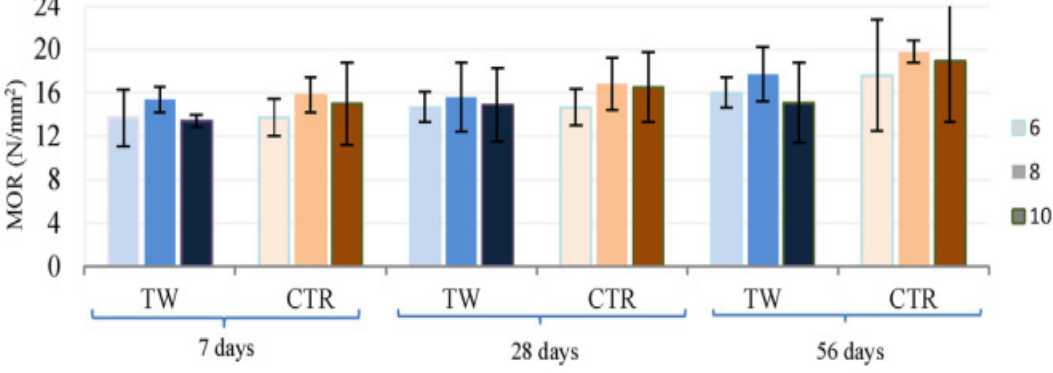
Figure 7. Moduli of rupture of the composites at different ages with various recycled waste fiber additions [53]. TW: textile waste; CTR: control kraft pulp.